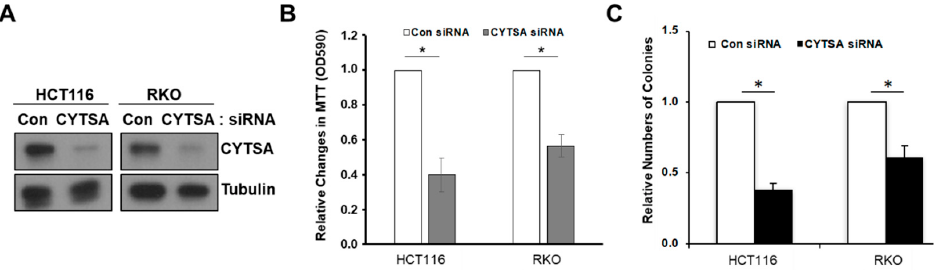
Figure 1. Depletion of CYTSA in CRC cells inhibit cell proliferation. ( A ) HCT116 (left panel) or RKO (right panel) cells were treated with Con siRNA or CYTSA siRNA. Levels of CYTSA and tubulin (loading control) from western blots are presented. ( B ) HCT116 and RKO cells transfected with Con siRNA or CYTSA siRNA were grown for 96 h, and cell growth was measured by MTT assay. OD values for Con siRNA were given the value of 1.0, and relative cell growth for CYTSA siRNA-treated cells was plotted. * p < 0.05. ( C ) HCT116 or RKO cells treated with Con siRNA or CYTSA siRNA and were grown for 7 days. Numbers of colonies from each set were counted and plotted. Colony numbers of CYTSA siRNA-treated cells are shown relative to those of Con siRNA-treated cells taken as one. The results shown are from at least three experiments. * p < 0.05.